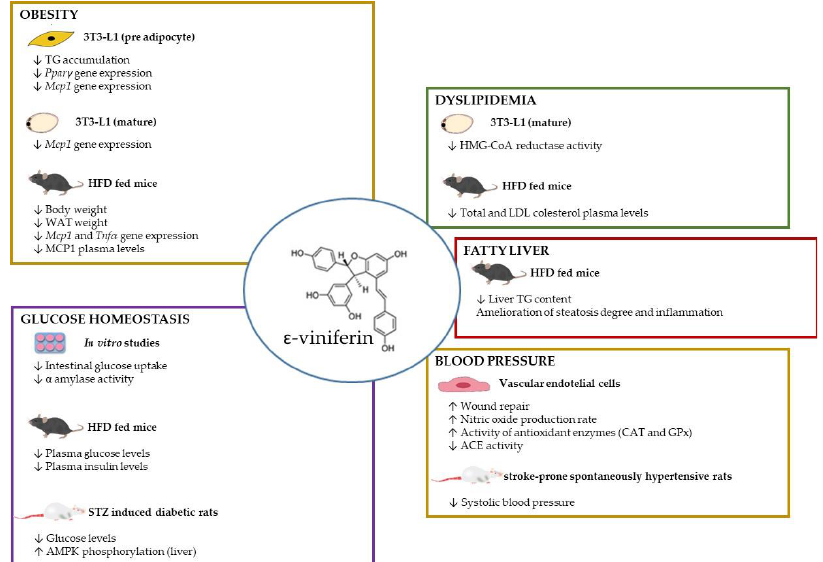
Figure 4. Schematic representation of ε -viniferin effects in obesity and related health alterations. ACE: angiotensin-converting enzyme, AMPK: AMP kinase, CAT: catalase, GPx: glutathione peroxidase, HFD: high-fat diet, Mcp1 : monocyte chemoattractant protein-1, Pparγ : peroxisome prolifera- tor-activated receptor gamma, TG: triglyceride, WAT: white adipose tissue.